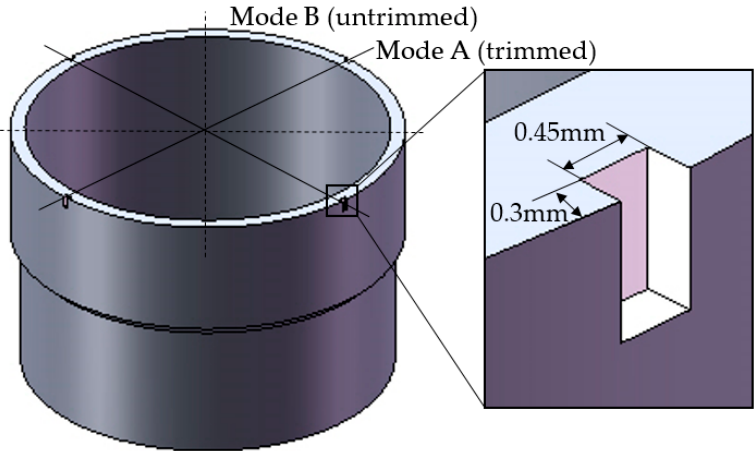
Figure 6. Forming grooves on the top edge of the resonator.